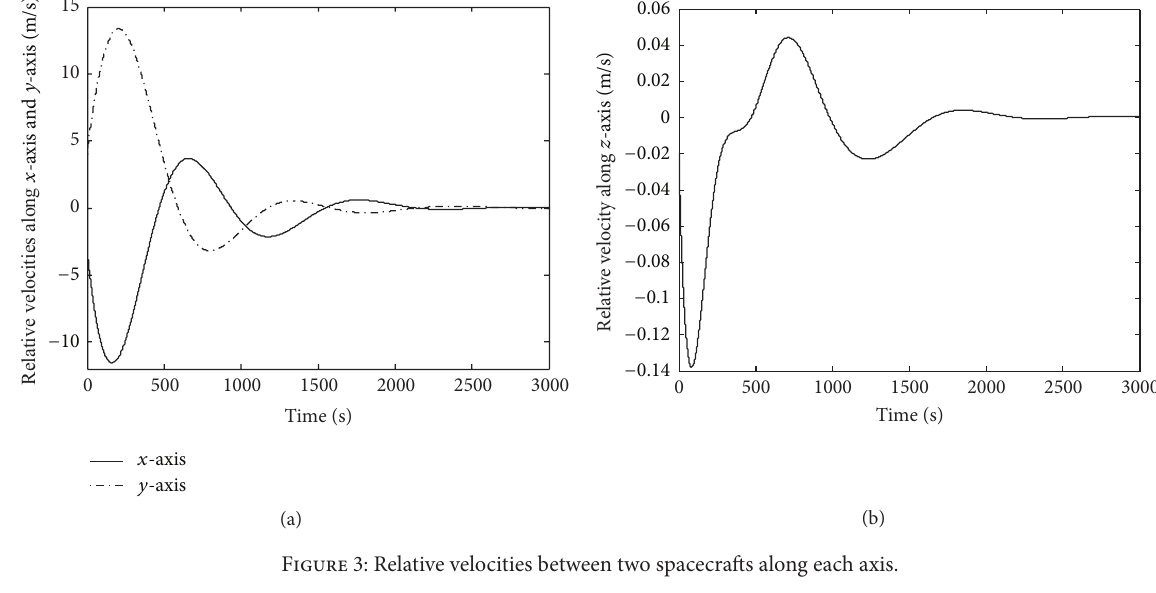
Figure 3: Relative velocities between two spacecrafts along each axis.